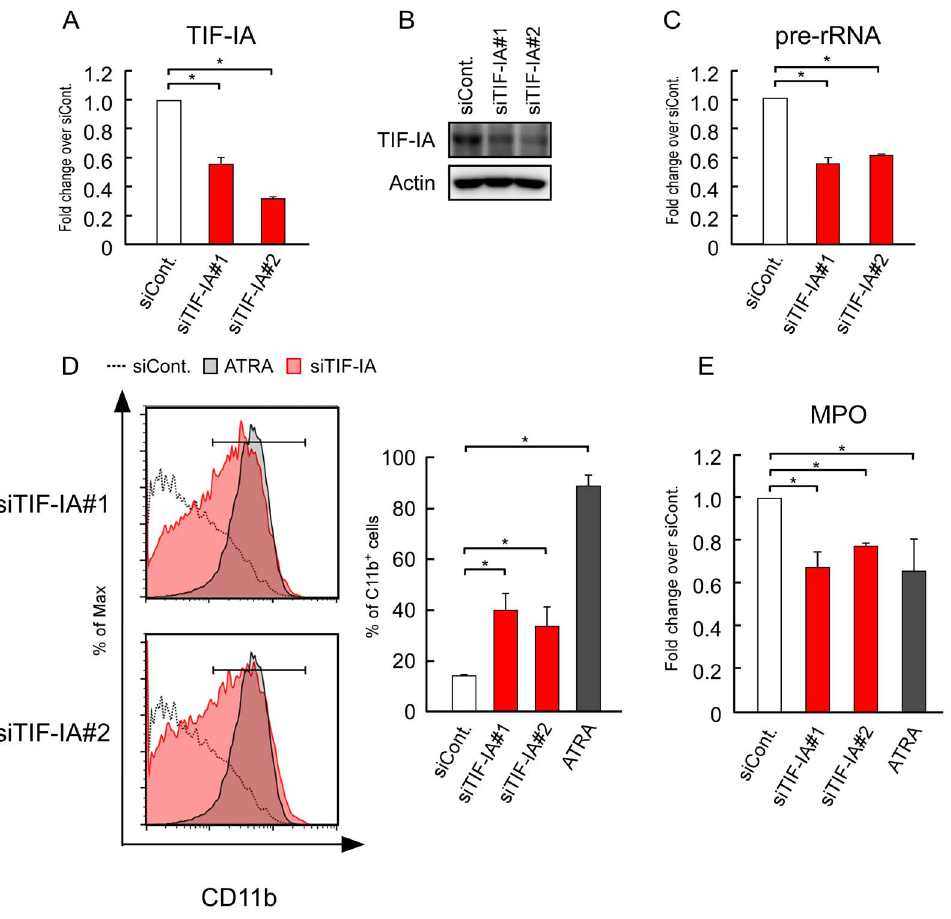
Figure 2. Suppression of rRNA transcription by TIF-IA KD induced the differentiation of HL-60. (A, B) siRNA-TIF-IA reduced the mRNA and protein levels of TIF-IA. HL-60 cells were transfected with siRNAs for luciferase (siCont.) and TIF-IA (siTIF-IA # 1 or siTIF-IA # 2), and cultured for 3 days. (A) The mRNA levels of TIF-IA were determined by RT-qPCR. (B) The protein levels of TIF-IA were determined by immunoblotting. (C) The pre- rRNA levels were determined by RT-qPCR. (D, E) TIF-IA KD induced the differentiation of HL-60 cells. (D) CD11b expression was determined by flow cytometry. ATRA (1 m M) was used as the positive control. The corresponding mean percentages of CD11b-positive cells are shown in the left panels (right panels). We present the same histograms for siCont. and ATRA in the upper and lower panels because these experiments were performed at the same time. (E) The MPO levels were determined by RT-qPCR and normalized by the cyclophilin levels. Values are expressed as the mean 6 S.D., n =3 (A, B, D). Values are expressed as the mean 6 S.D., n =4 (C). * P , 0.05.